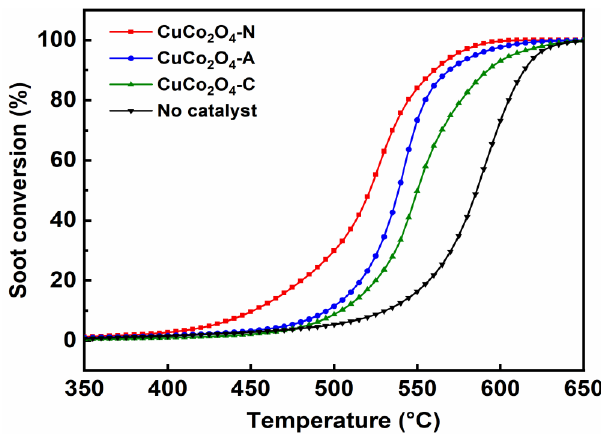
Table 3. Catalytic activity of the CuCo 2 O 4 - x ( x = N, A and C) catalysts for soot combustion under loose contact mode in 10 vol.% O 2 with balanced N 2 .